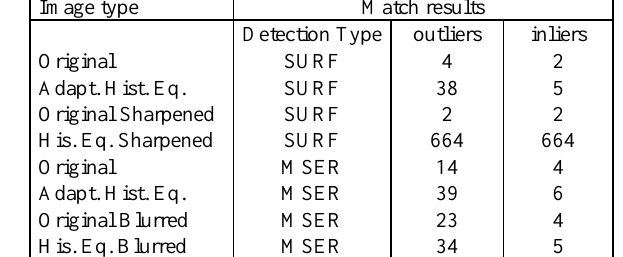
Figure 6. SURF algorithm applied on sharpened adaptive histogram equalization image